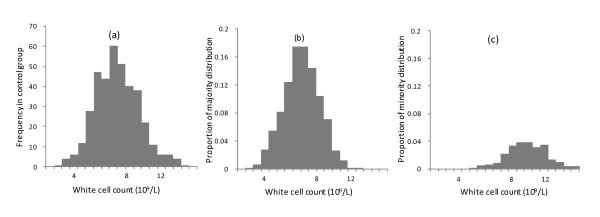
Distribution of total white cell count, and its decomposition into two Gaussian distributions. Histogram (a) shows loge transformed raw data. Histograms (b) and (c) are generated from parameter estimates obtained by applying a Gaussian mixture model to loge (white cell count). They represent the 'best' mixture to replicate the overall distribution: i.e. two distributions tended to provided a better fit (likelihood ratio test, 3 degrees of freedom, χ2 = 7.25, p = 0.06), (b) representing 80% of data, (c) a shift-to-the-right. There was no evidence that a mixture of Gaussian distributions provided a better fit to distribution of loge transformed lymphocyte (age-corrected) or neutrophil counts (χ2 = 0.74 & 3.49, p = 0.9 & 0.3, respectively).